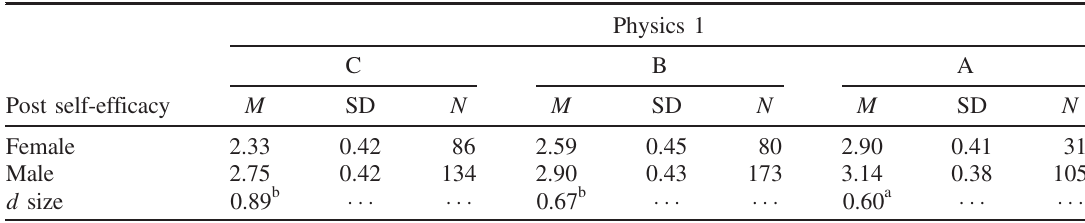
TABLE VII. Self-efficacy scores in physics 1 binned by course grade (A, B, C) for female and male students M ¼ mean, SD ¼ standard deviation, N ¼ number of students), along with Cohen ’ s d for the gender contrast in